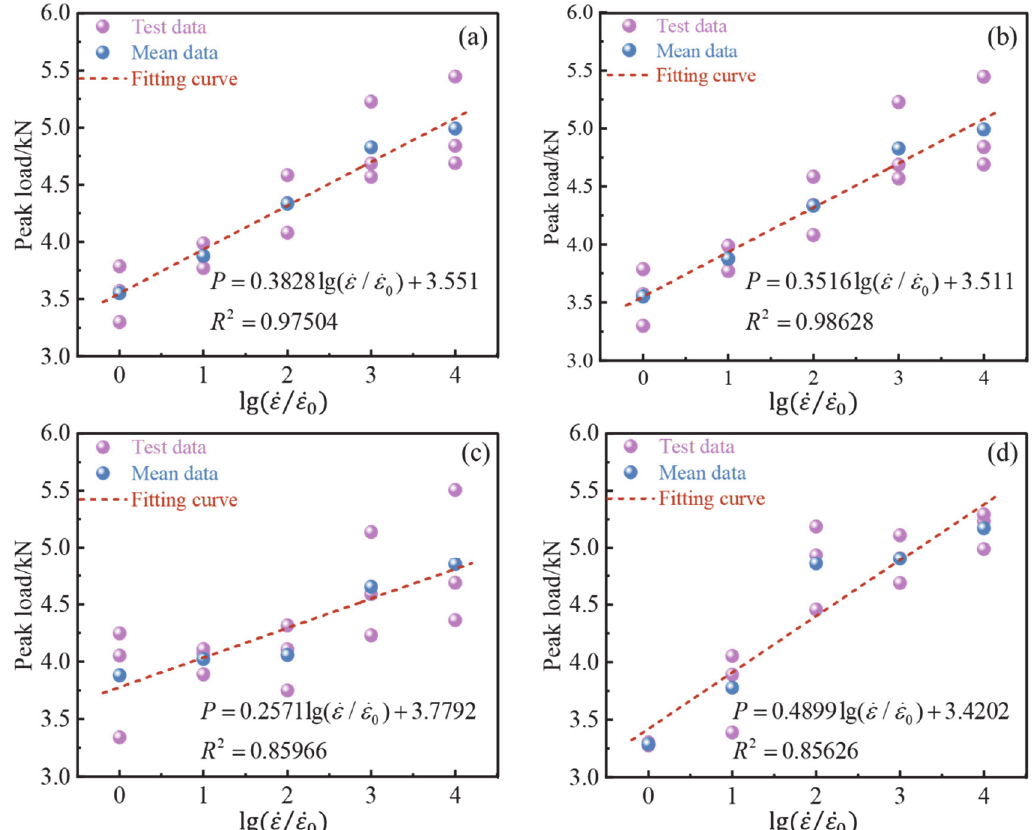
Figure 6. The relationship between the peak load and strain rate: ( a ) OPC; ( b ) B ‐ 0.2; ( c ) B ‐ 0.4; and ( d ) B ‐ 0.6.